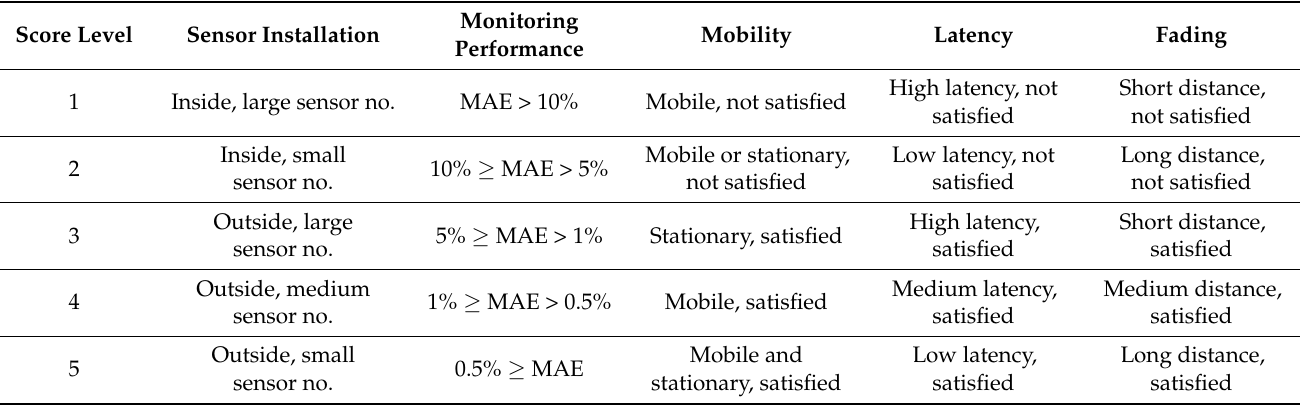
Table 1. Attribute scoring principle for SBMS-ES.